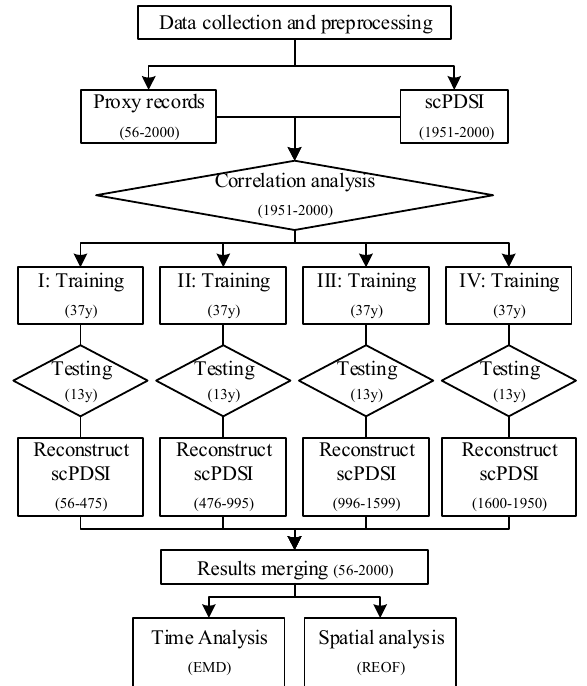
Figure 3. Flowchart of the reconstruction model.